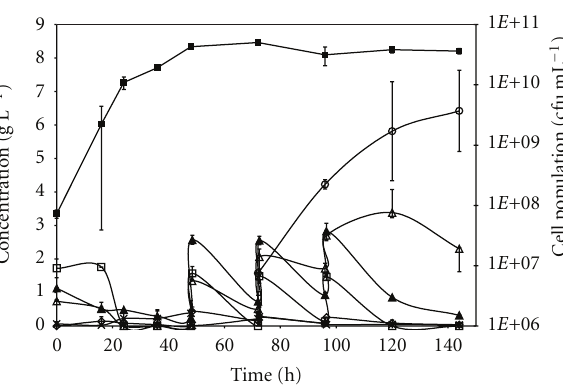
Figure 1: Average growth rate and organic acid utilization during the initial 48 h incubation in the CCS medium. The values for average cell count ( (cid:2) ), acetic acid utilization ( (cid:3) ), butyric acid utilization ( ♦ ), lactic acid utilization ( (cid:5) ) propionic acid utilization, ( (cid:6) ) and succinic acid utilization ( × ) are indicated. Values are the means of two replications with standard deviation showed by error bars.